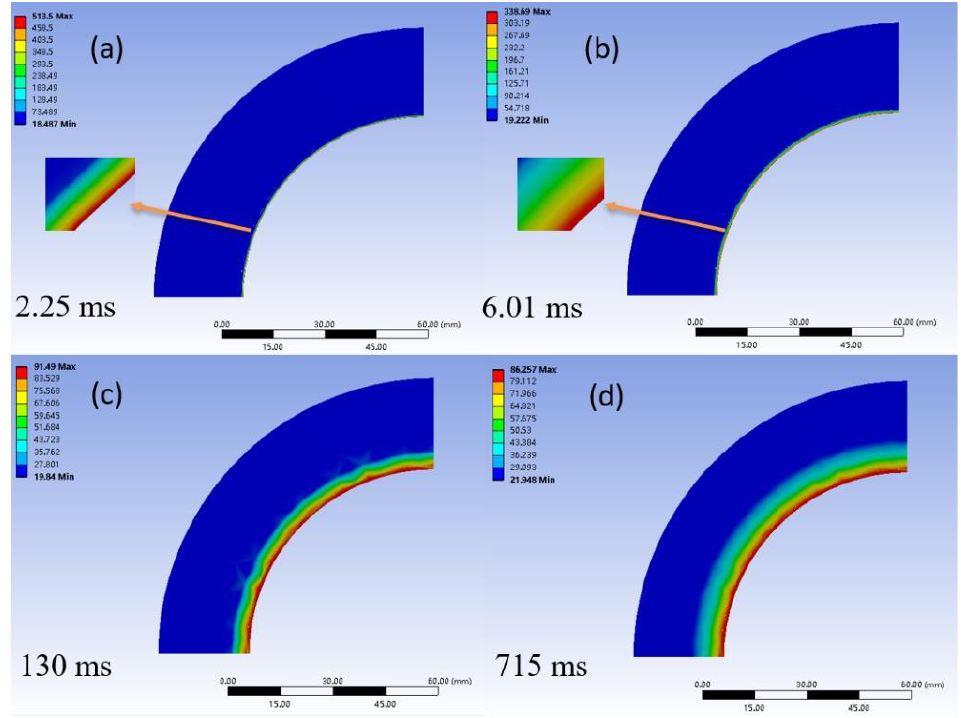
Figure 5. Cloud diagrams of the temperature of the A section (Cr coating). ( a ) 2.25 ms, ( b ) 6.01 ms ( c ) 130 ms and ( d ) 715 ms after the gun is fired.